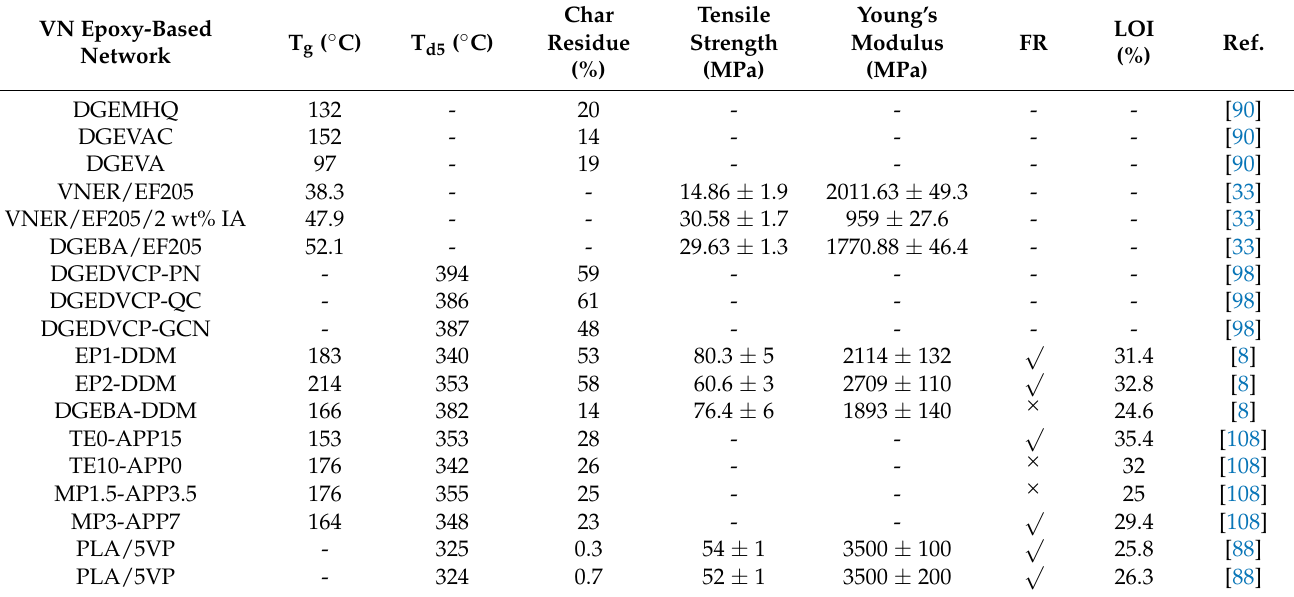
Table 2. A summary of thermal and mechanical properties of VN epoxy-based